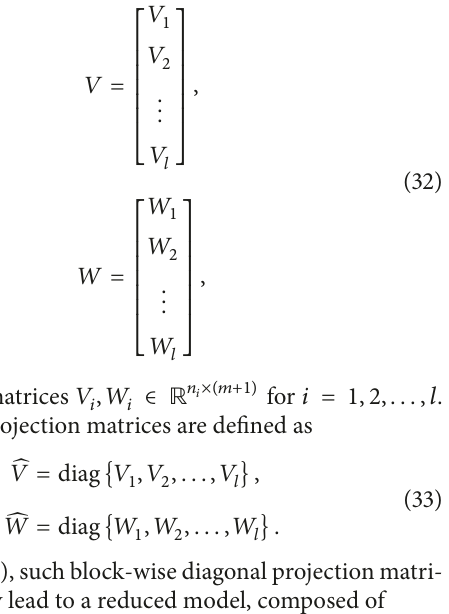
Algorithm 4 (derivative-extended reduction method for cou- pled